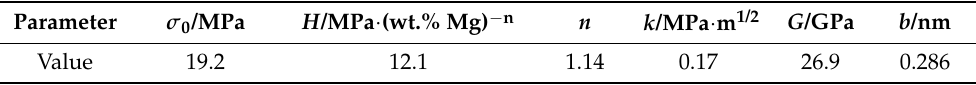
Table 2. Coefficients in the strength calculation formula [26,29,30].